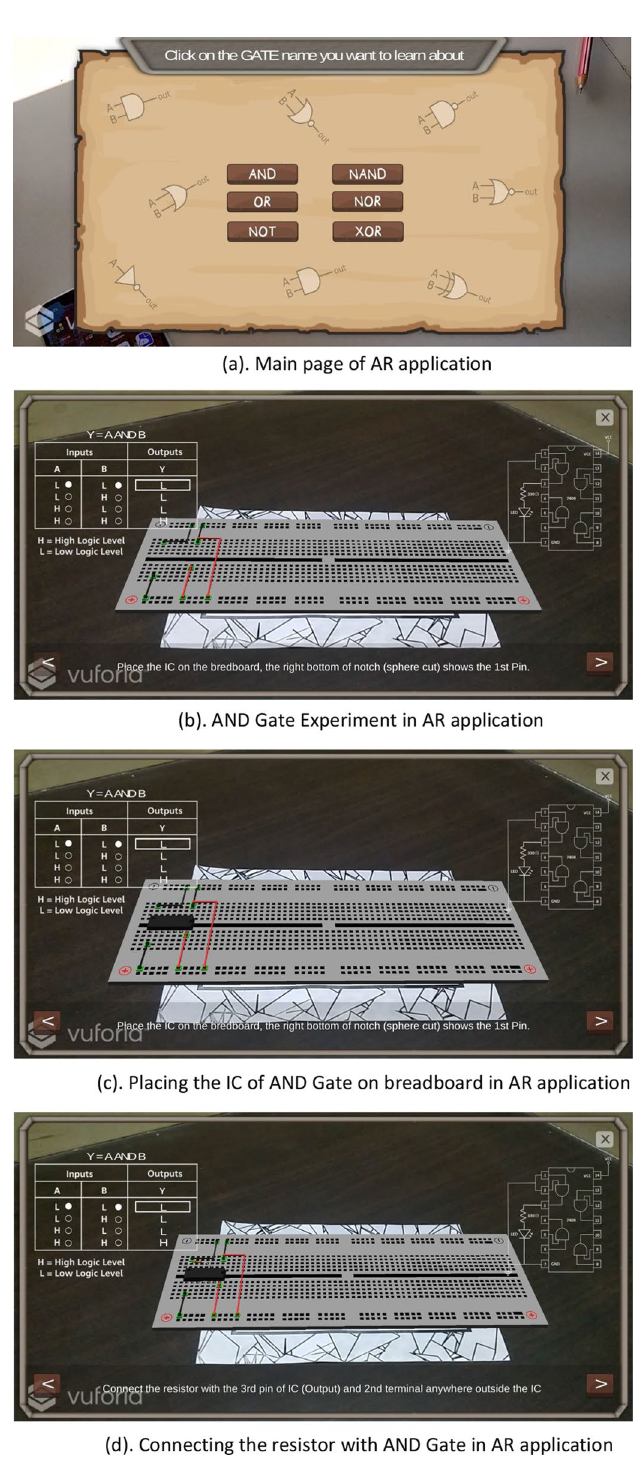
Fig. 3 a Main page of AR application. b AND gate experiment in AR application. c Placing the IC of AND Gate on breadboard in AR application. d Connecting the resistor with AND Gate in AR application. e Connecting the LED with AND Gate in AR application. f LED is off when the user selects (LOW, LOW) as the input in AR application. g LED glows when the user selects (HIGH, HIGH) as the input in AR